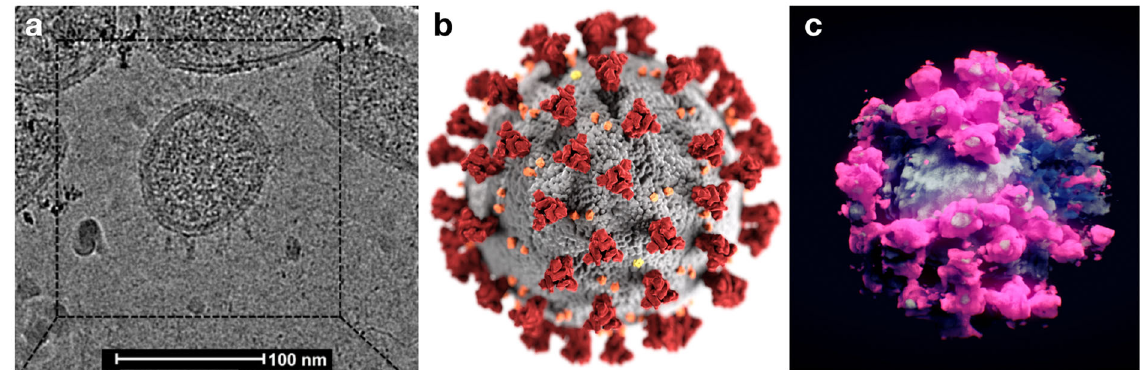
Fig. 2 Scienti fi c illustrations of the SARS-CoV-2 coronavirus. a The fi rst higher-resolution cryogenic electron microscopy image, obtained by the Cryo-EM Centre of the Southern University of Science and Technology . This fi gure is not covered by the Creative Commons Attribution 4.0 International License. Reproduced with permission of Professor Peiyi Wang; copyright © Cryo-EM Centre of SUSTech available at https://www.biorxiv.org/content/10.1101/ 2020.03.02.972927v1.full.pdf, all rights reserved. b Illustration created at the Centers for Disease Control and Prevention ( CDC ) by Alissa Eckert and Dan Higgins. Source CDC, public domain and thus free of any copyright restrictions at https://phil.cdc.gov/Details.aspx?pid = 23312. c Infographic based on cryo-electron tomography, created in false colour by Nanographics using data from Tsinghua University . This fi gure is covered by the Creative Commons Attribution 4.0 International License. Reproduced with permission of Nanographics at https://nanographics.at/projects/coronavirus-3d/ copyright © Nanographics, all rights reserved.